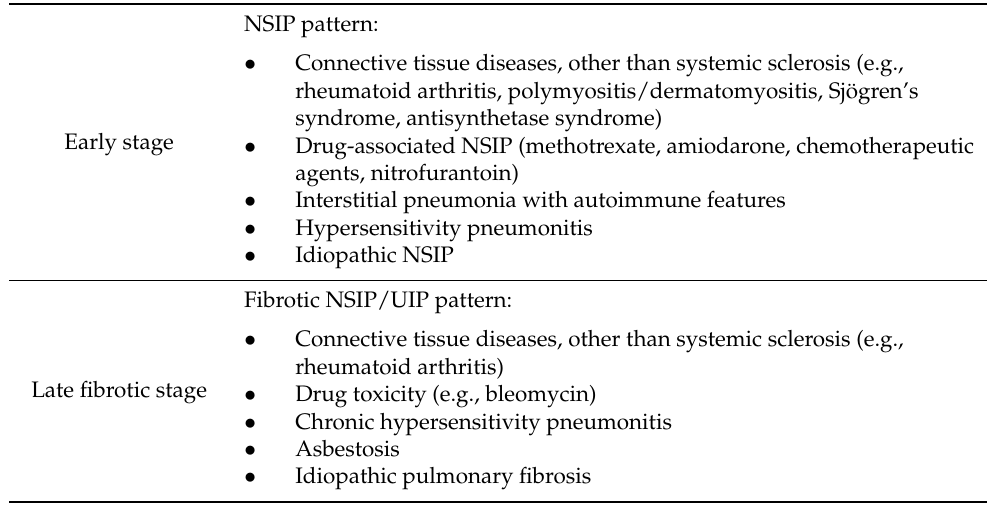
Figure 5. Esophageal involvement in a 42-year-old female with a diagnosis of SSc. Axial image with a mediastinal window setting shows a dilatation of the esophagus (diameter >1.2 cm) with an air-fluid level. Table 1. Main HRCT differential diagnoses of systemic